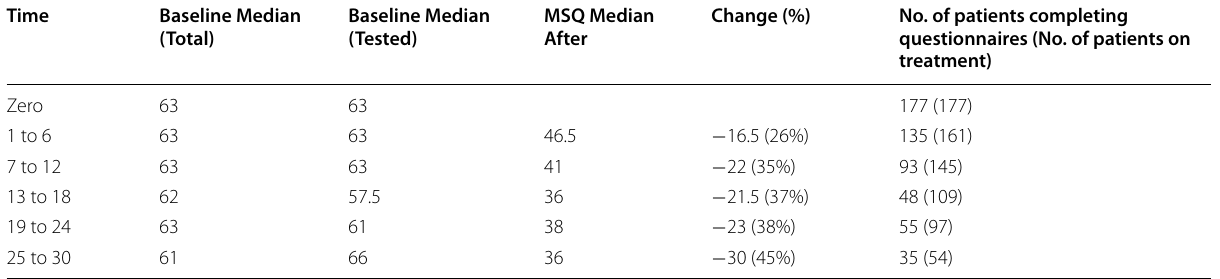
Table 4 Median MSQ score at baseline and follow up in months. Median difference in MSQ compared to baseline and percentage in MSQ compared to baseline. Proportion of patients contributing to the